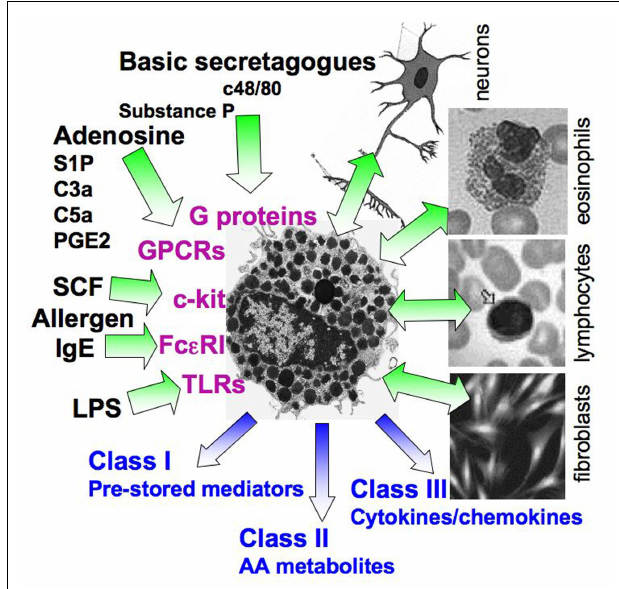
FIGURE 1 | Complexity of MC activation. A scheme illustrating the multiple stimuli that can activate MCs.The latter include the